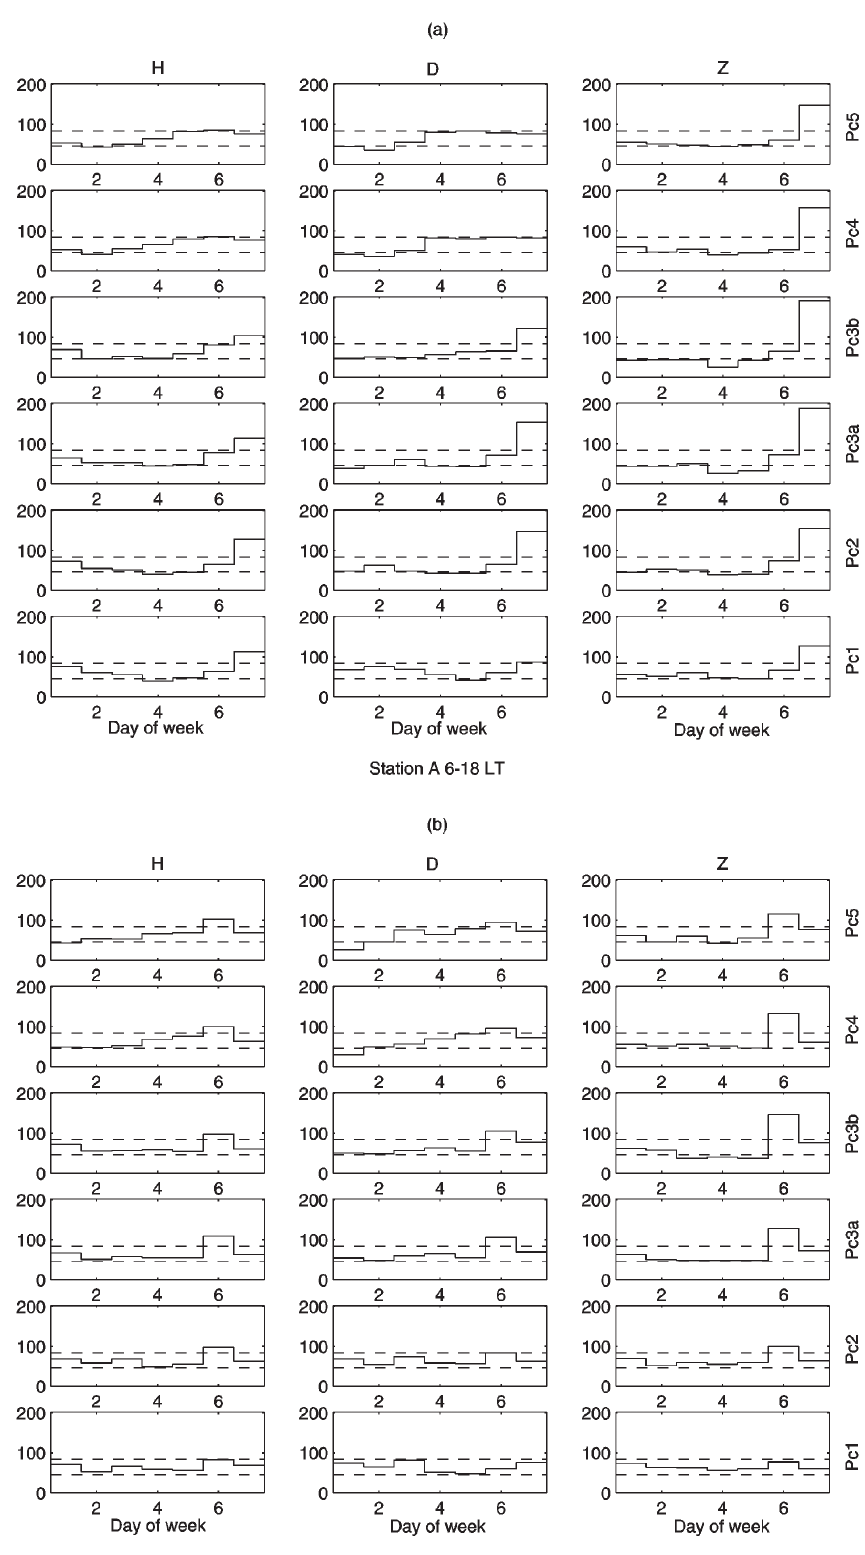
Fig. 4. Weekly distribution of the lowest values of power (5% of the whole population) in different frequency bands at Station A. Dashed lines identify the 99% confidence interval. (a) daytime interval; (b) nighttime